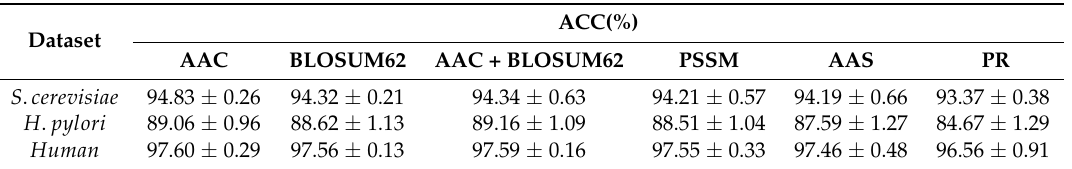
Table 7. Comparison of different protein representation approaches by our